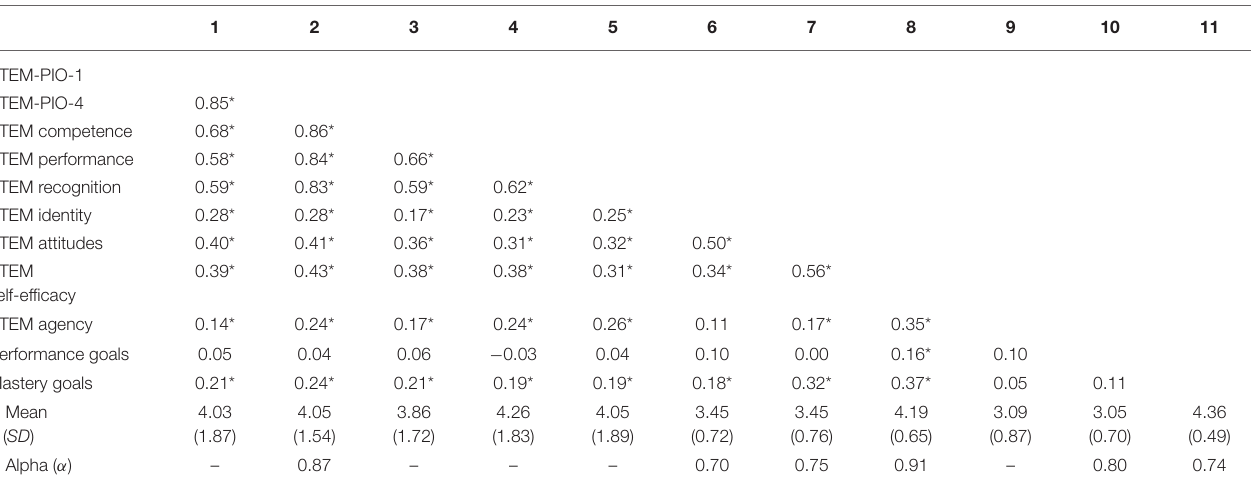
TABLE 4 | Descriptive statistics for measured variables in study